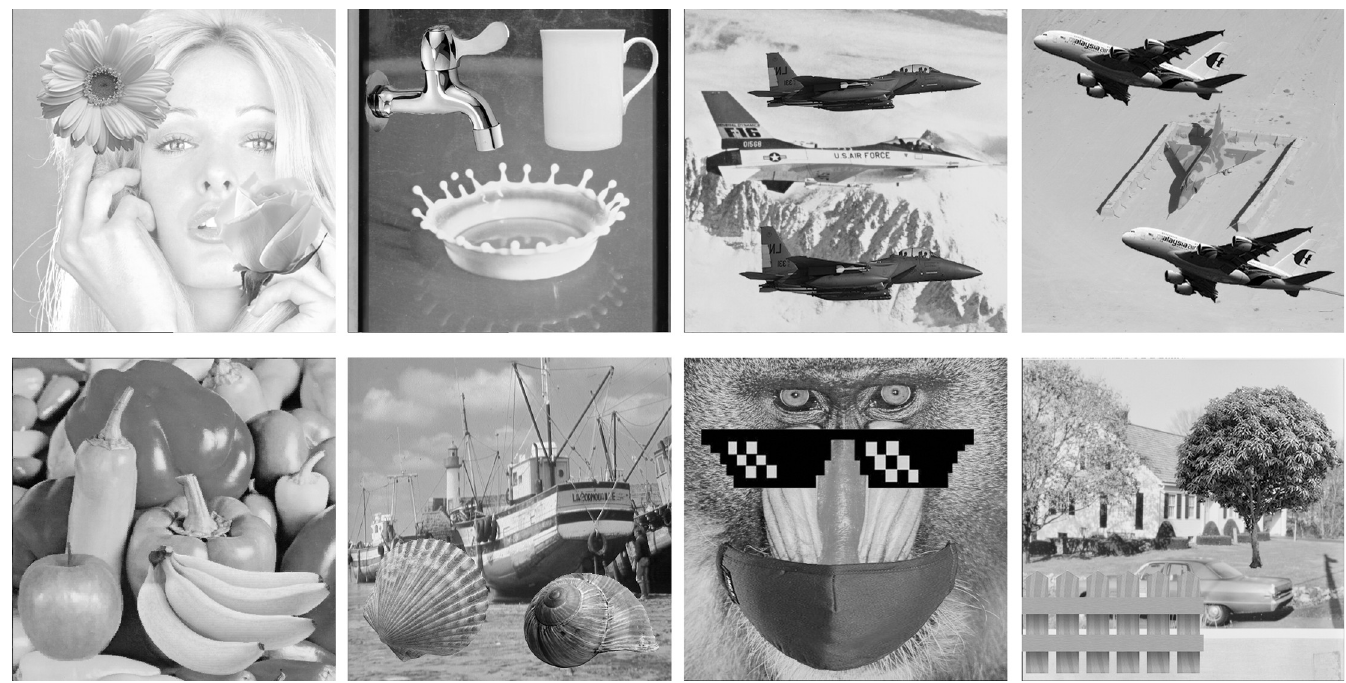
Fig 12. Eight tampered test images of size 512 × 512. (a) Tiffany. (b) Splash. (c) Jet. (d) Airplane. (e) Peppers. (f) Boat. (g) Baboon. (h) House.